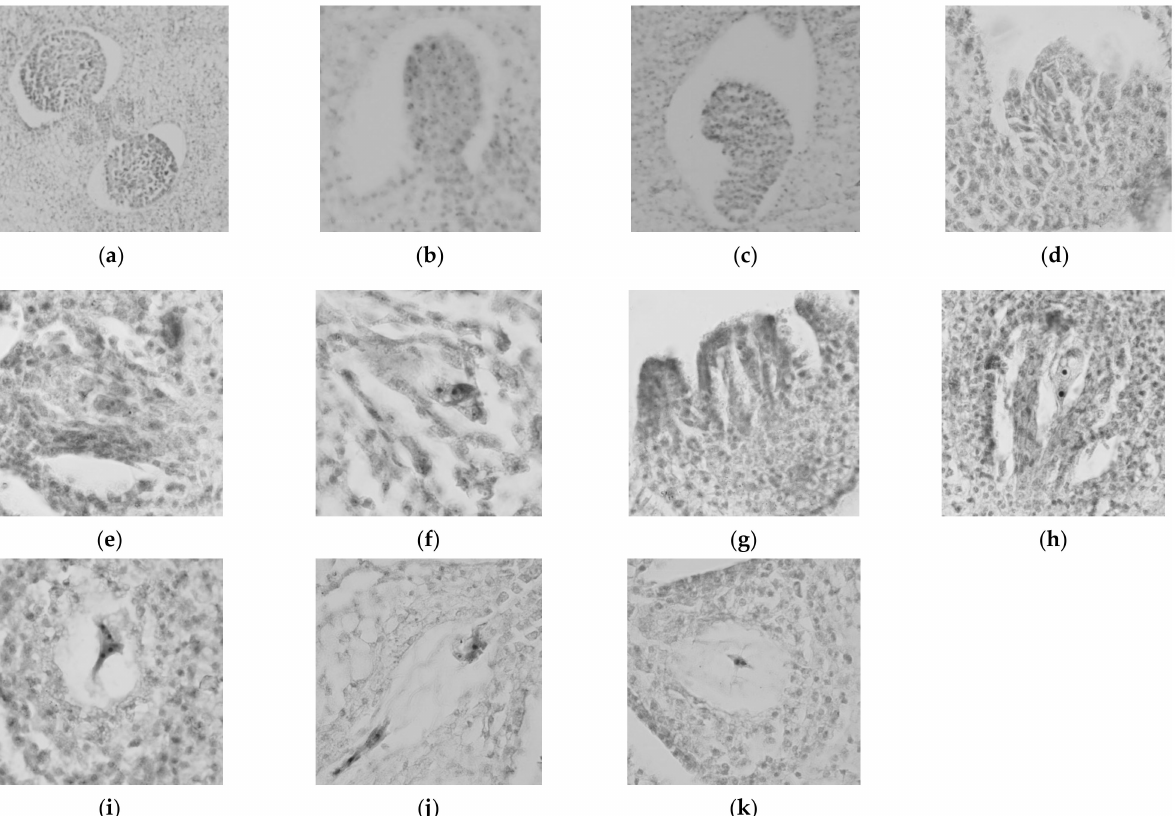
Figure 3. Megasporogenesis and the development of female gametophyte ( a – k scale bar = 20 µ m). ( a ) Longitudinal section of flower bud; ( b ) ovule primordia; ( c ) new formed ovule primordial; ( d ) megaspore mother cell; ( e ) dyad period; ( f ) tetrad stage; ( g ) mononuclear embryo; ( h ) two-nucleate embryo; ( i ) tetranuclear embryo; ( j , k ) octonucleate embryo.